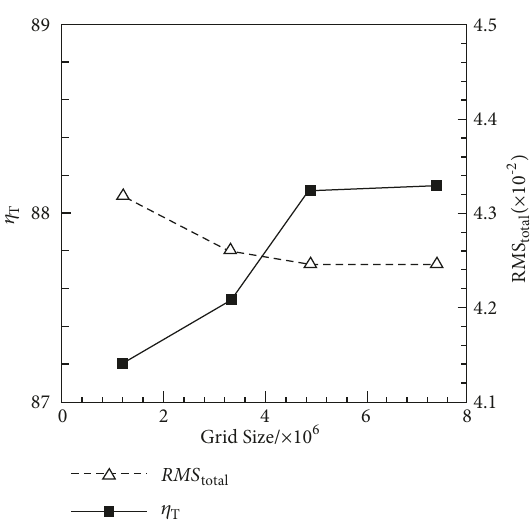
Figure 4: Grid sensitivity analysis for straight vane case.